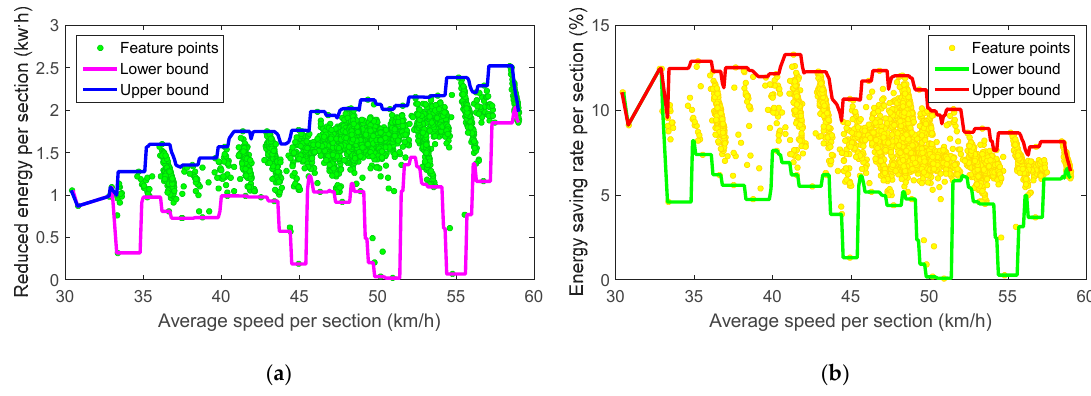
Figure 13. Boundaries of ASS-REN-PLF and ASS-RER-PLF profiles (weekend, TQ-SH, N p = 593). ( a ) ASS-REN-PLF profile result; ( b ) ASS-RER-PLF profile result.